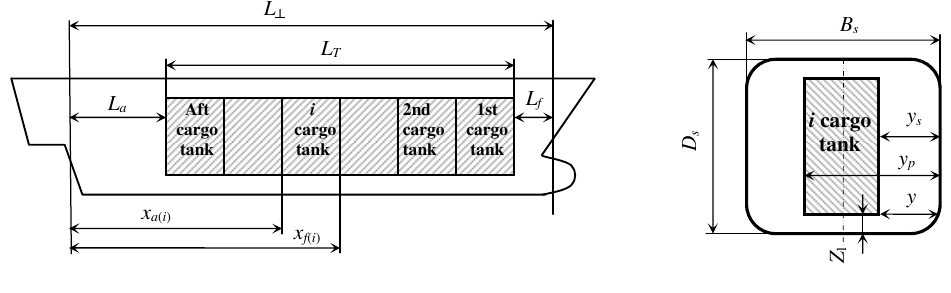
Fig 1. Dimensions of i cargo tank of the tanker: